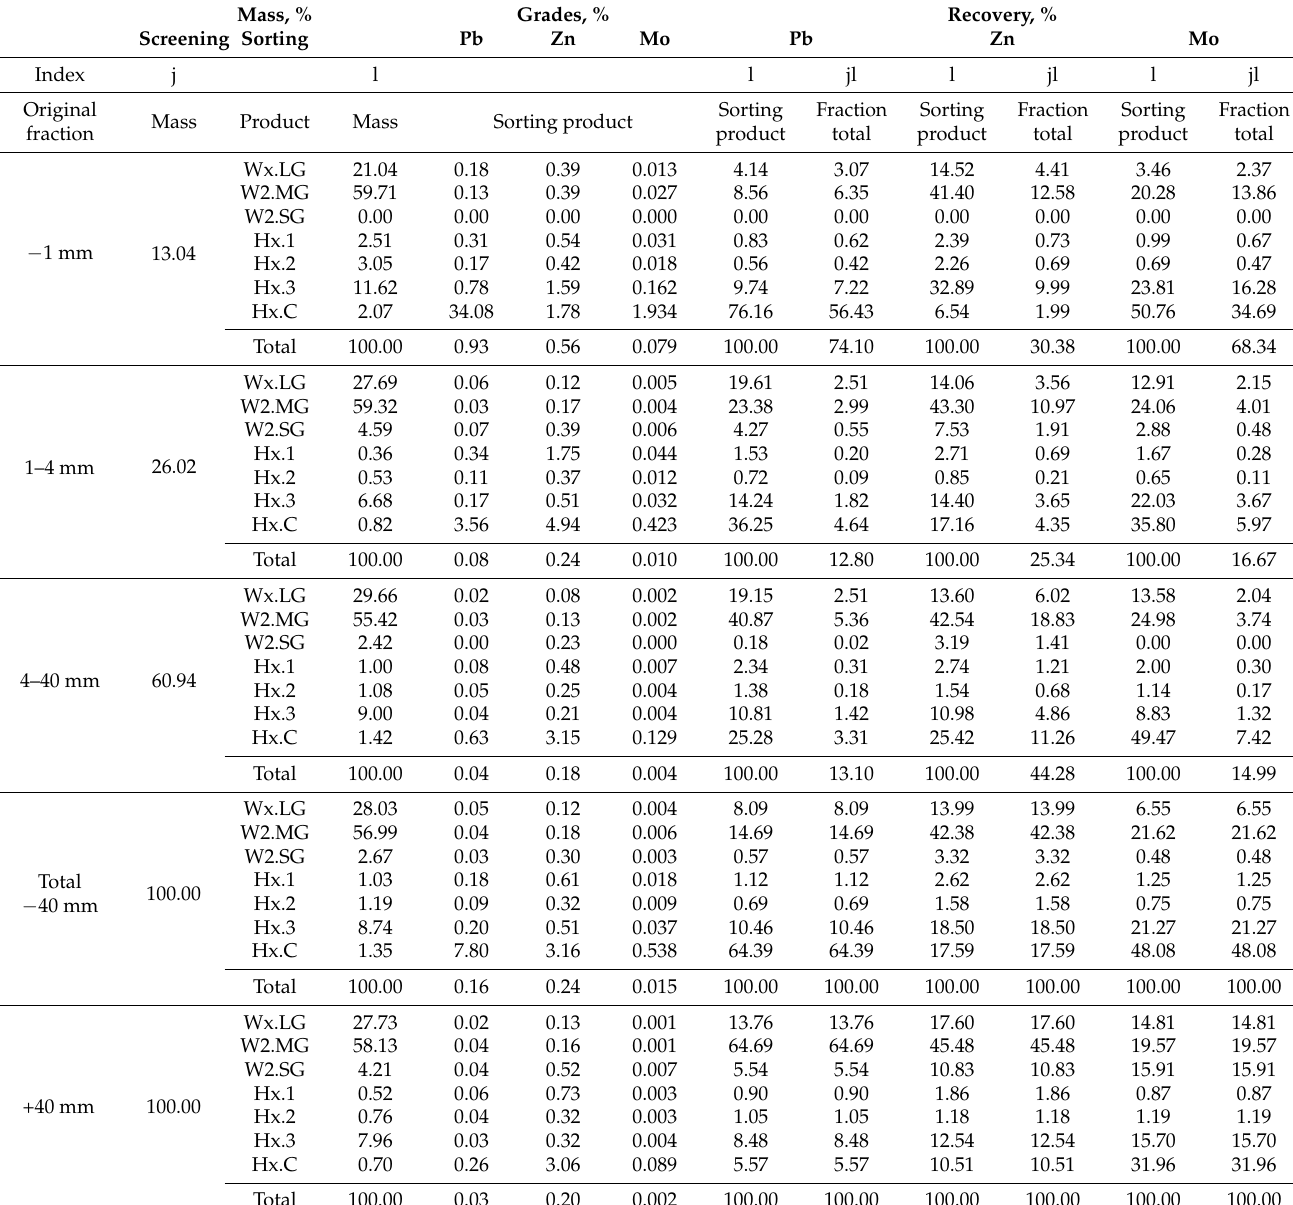
Table 9. Balanced results of the gravity concentration trials. The sorted 30–315 µ m and 315–1000 µ m fractions are combined into the 30–1000 µ m fraction for clarity; sample A1